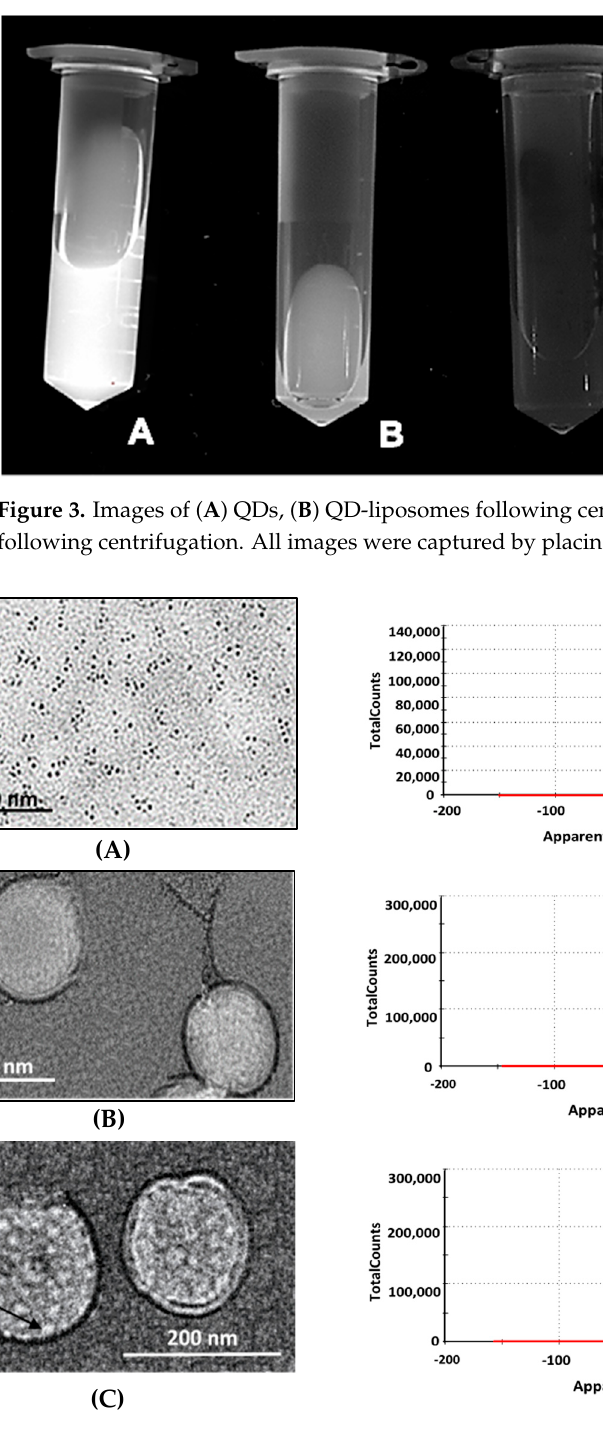
Figure 4. TEM images of free green graphene QDs ( A ), free liposomes ( B ) and QD ‐ liposomes ( C ), as well as zeta potentials distribution for the free QDs ( D ), free liposomes ( E ) and QD ‐ liposomes ( F ).